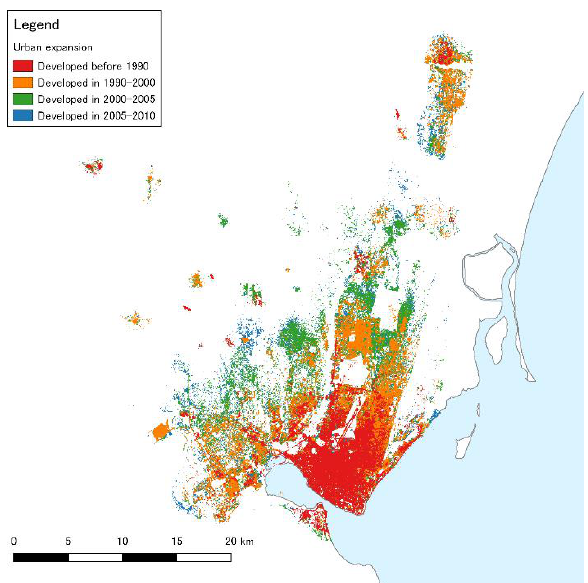
Figure 1. Improved result for Maputo with supplemental data of initial built-up